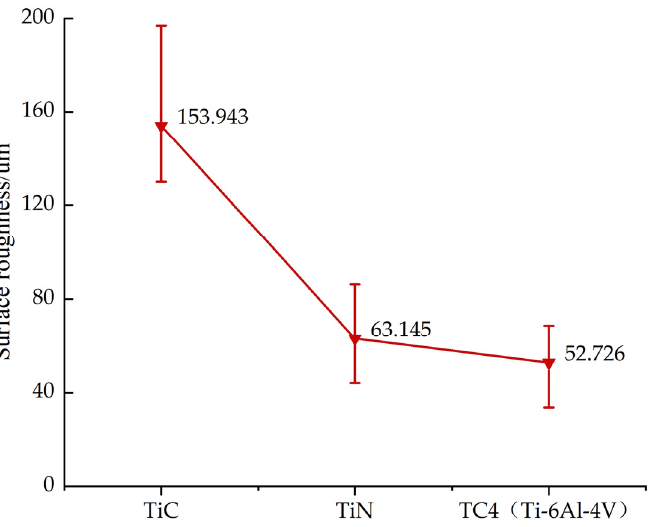
Figure 11. Comparison of resistivity and deposition surface roughness of different materials.